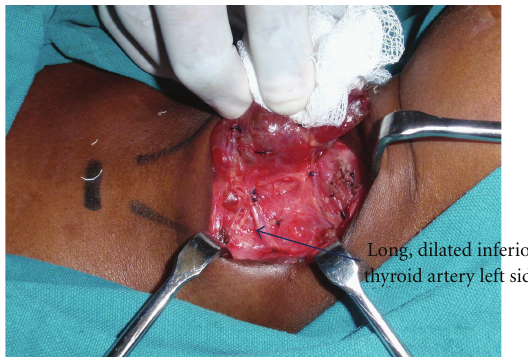
Figure 4: It depicts the long dilated inferior thyroid artery of the left